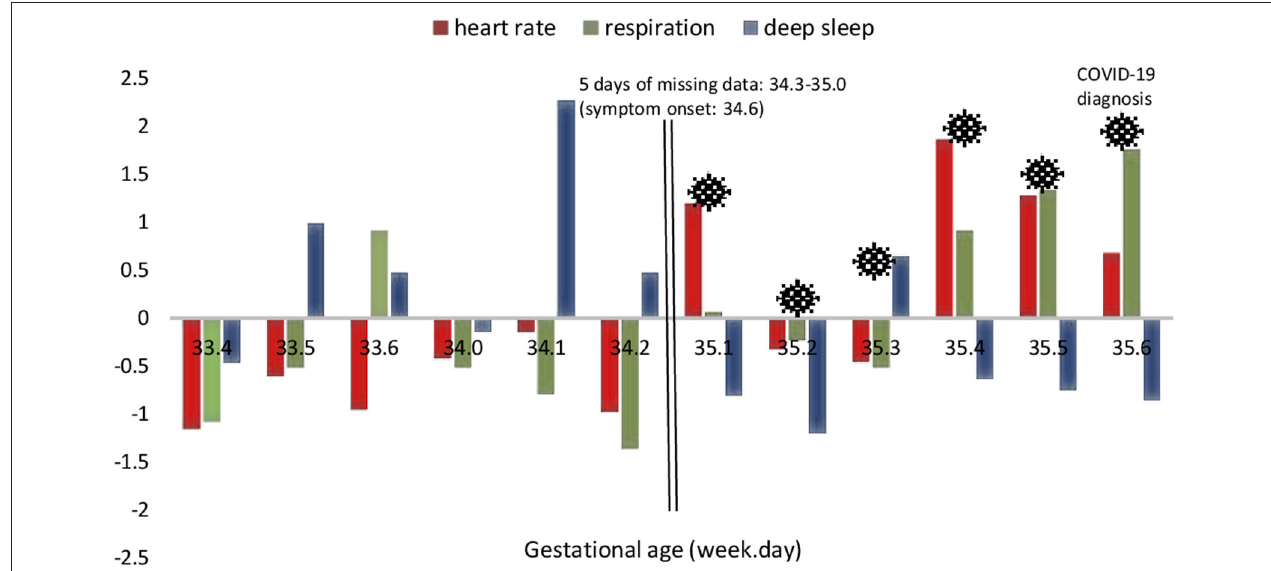
FIGURE 2 | Case II: daily standardized scores of selected physiological parameters surrounding the period of COVID-19 infection.